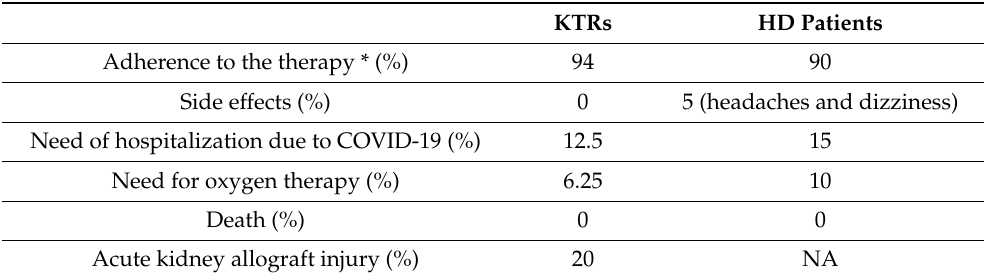
Table 2. Data concerning safety and tolerability of molnupiravir use in ESKD. KTRs HD Patients Adherence to the therapy * (%) 94 90 Side effects (%) 0 5 (headaches and dizziness) Need of hospitalization due to COVID-19 (%) 12.5 15 Need for oxygen therapy (%) 6.25 10 Death (%) 0 0 Acute kidney allograft injury (%) 20